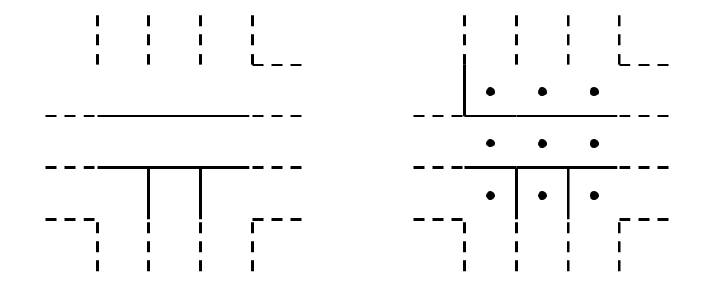
Figure 10 . Comparison of non-trivial centers: the left (cid:12)gure corresponds to the ^ A (or (cid:25) ) center algebra of our model with square region of size n = 3, while the right (cid:12)gure corresponds to the electric center algebra of Casini’s model [20] with square region of size n = 3. Only physical degrees of freedom have been kept in both (cid:12)gures. In the left (cid:12)gure, solid links correspond to both ^ A and (cid:25) , while dashed links correspond to keeping only the operators ^ A (or (cid:25) ) in the algebra, which form a center. In the right (cid:12)gure, both solid links and dashed links correspond to the electric operators and dots correspond to the magnetic operators. The electric operators on dashed links commute with all other operators and form a center. We can see that the two centers (dashed links) are the same in the